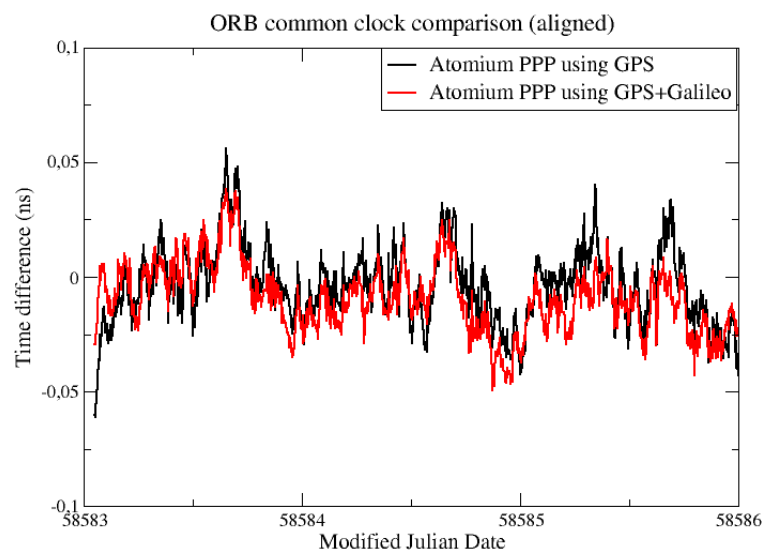
Figure 2. 3 days aligned CCD Galileo results from Figure 1.